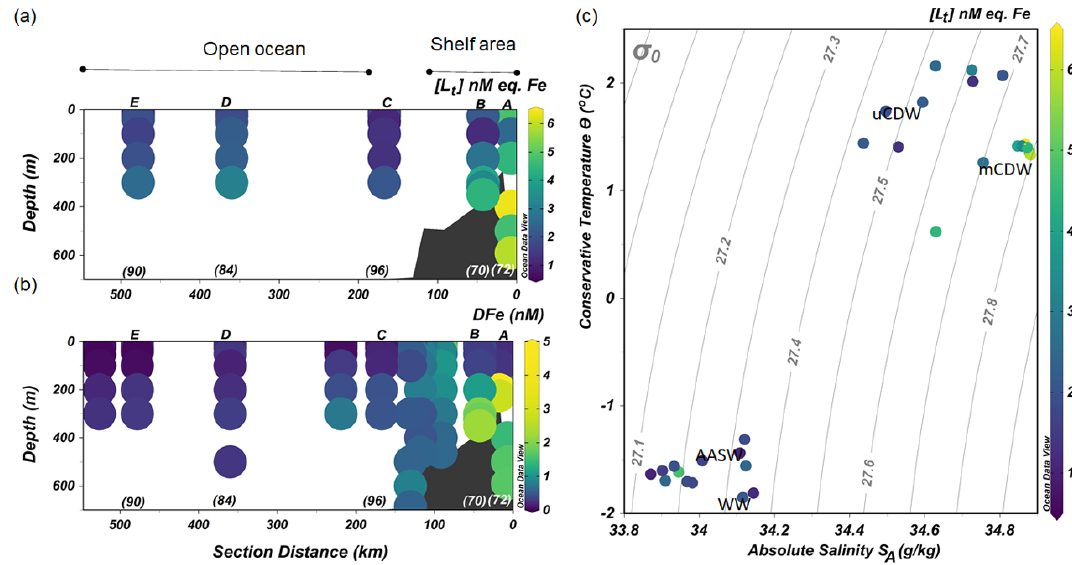
Figure 3. The distribution along the transect shown in Fig. 1 of (a) the concentrations of total Fe-binding ligands [ L t ] and (b) concentrations of dissolved Fe (DFe; data from Seyitmuhammedov et al. (2021). (c) A diagram of (cid:50) and S A with colors denoting the values of [ L t ]. The letters above and numbers below the profiles in (a) and (b) indicate the stations. DFe data are presented using a nonlinear scale for